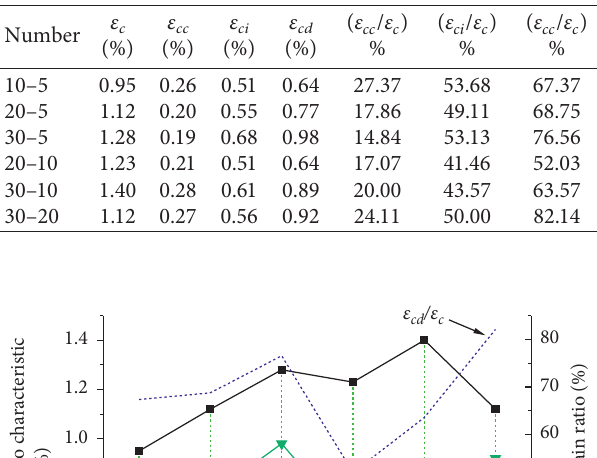
Figure 11: Variation law of characteristic stress ratio under dif- ferent confining pressure and pore water pressure conditions. Table 3: Data table of characteristic strain.